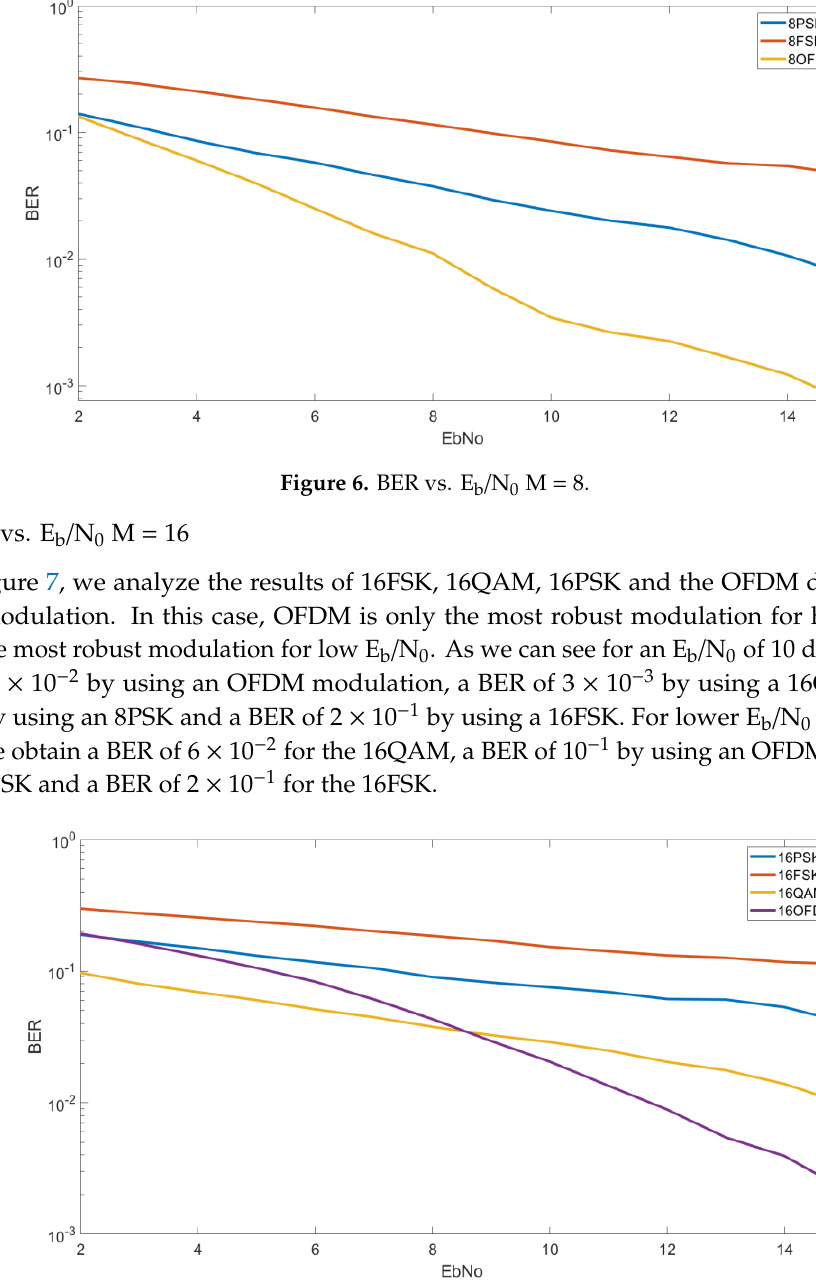
Figure 7. BER vs. E b / N 0 M = 16.